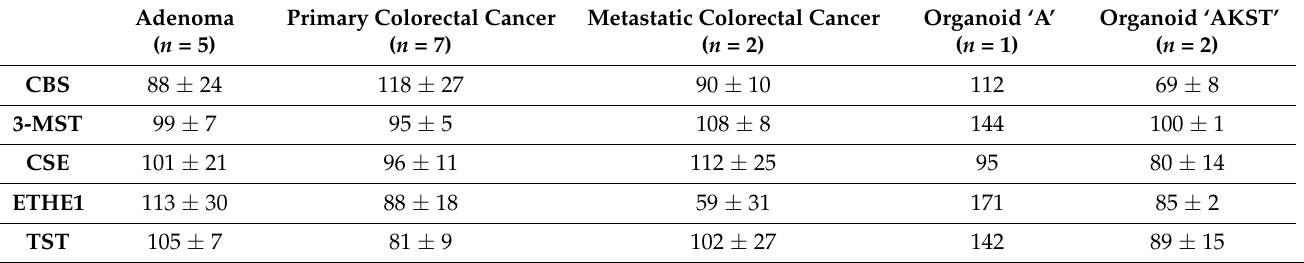
Table 2. Changes in the expression of H 2 S-producing and H 2 S-metabolizing enzymes during colorec- tal carcinogenesis (mRNA expression data) 1